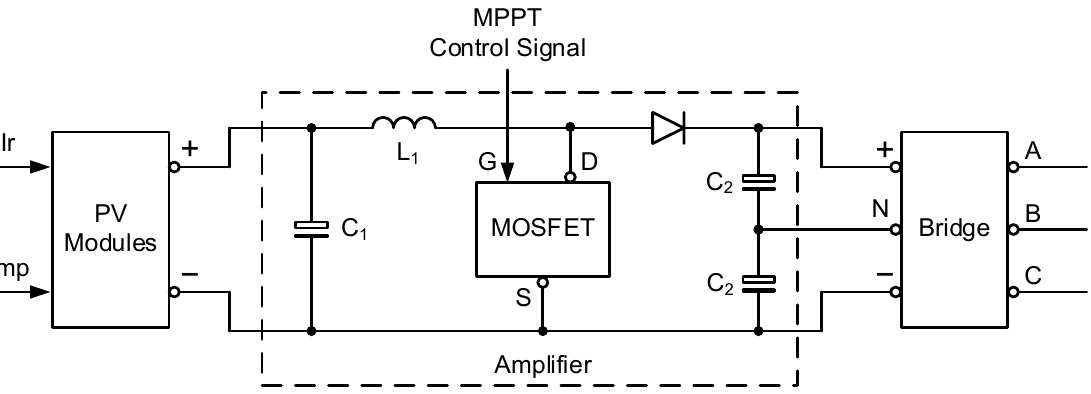
Figure 8. DC–DC boost converter together with a three-phase rectifier bridge, connected to a PV installation, implemented in Matlab/Simulink.